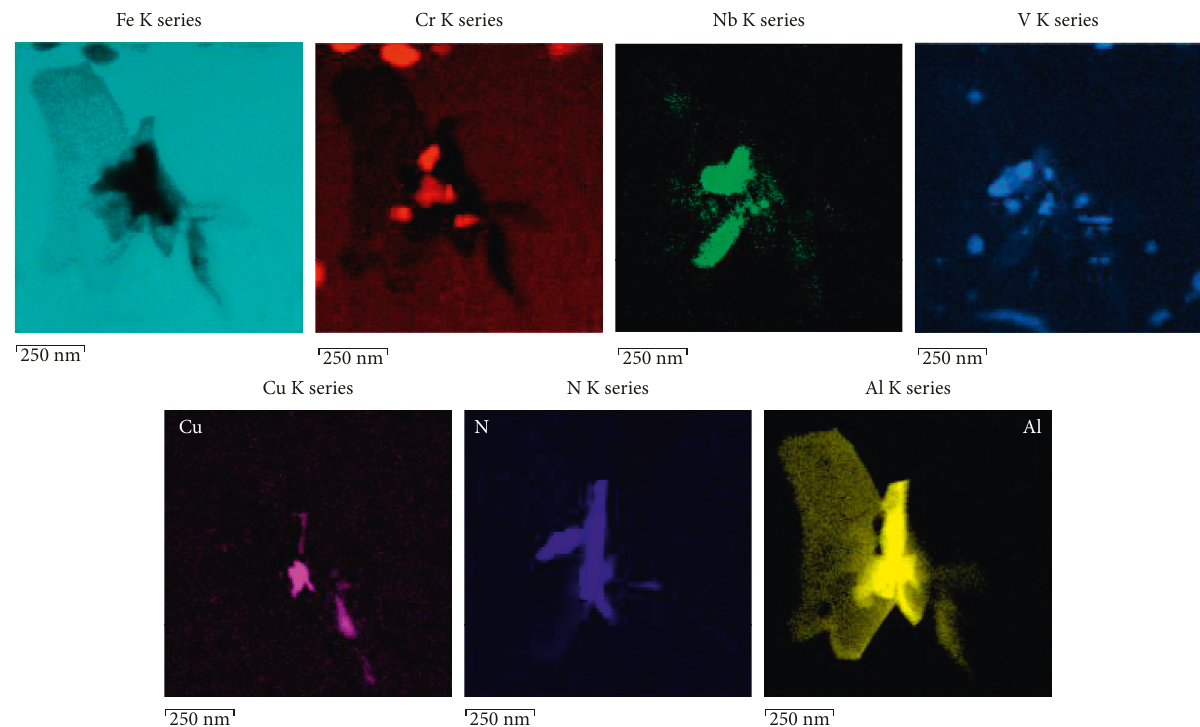
Figure 14: Detailed micrograph showing inclusions associated with an individual creep cavity as well as compositional maps showing the distribution of the elements Cr, Nb, V, Cu, N, and Al associated with this